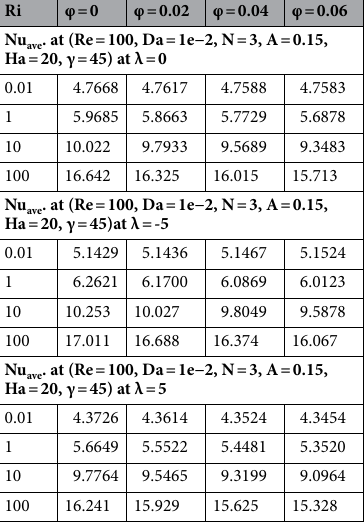
Table 8. Effect of Ri, ϕ and λ on the average Nusselt number for Case 1.